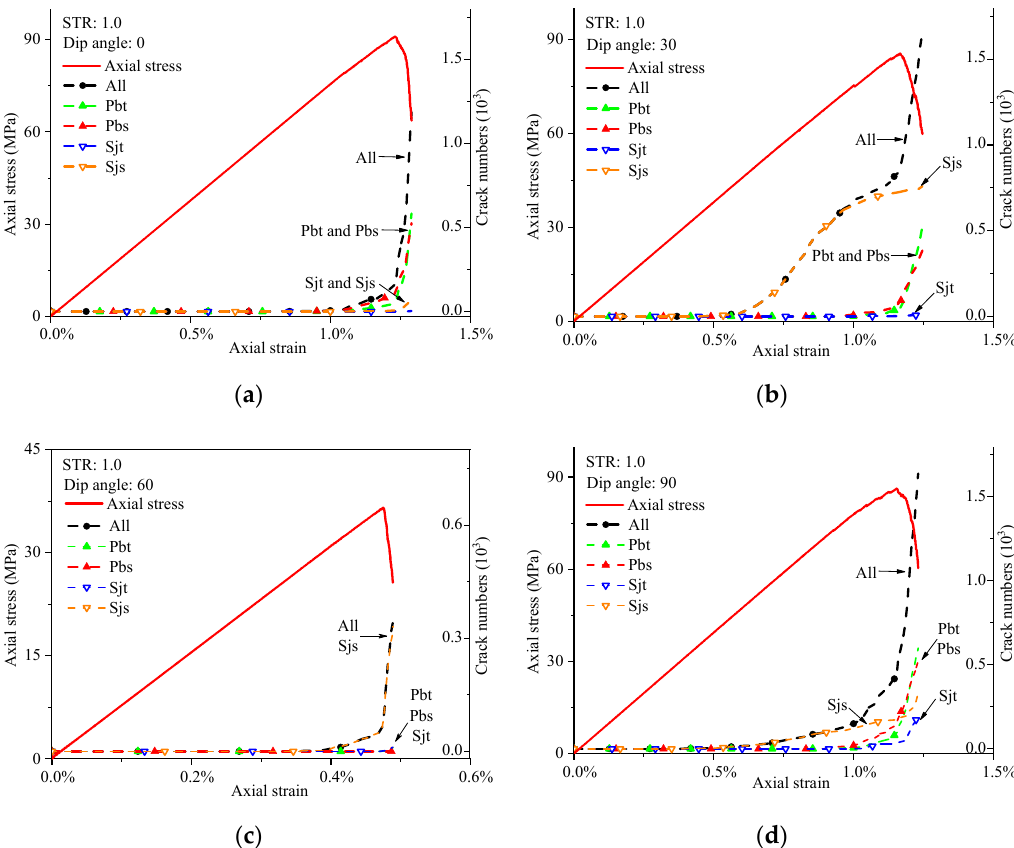
Figure 11. Stress-strain curves and evolution of micro-cracks simulated at di ff erent dip angles and in uniaxial compression (STR is 1.0). ( a ) dip angle = 0 ◦ ; ( b ) dip angle = 30 ◦ ; ( c ) dip angle = 60 ◦ ; ( d ) dip